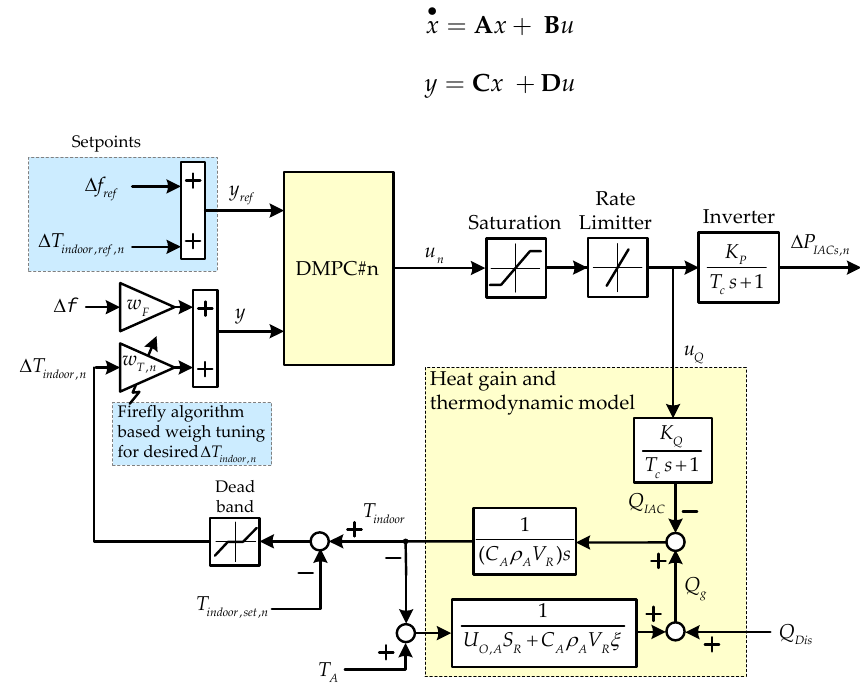
Figure 3. The multivariable DMPC for IACs control. Table 1. System Parameters. Parameters Value Reference frequency, f ref Inertia constant, H (sec)